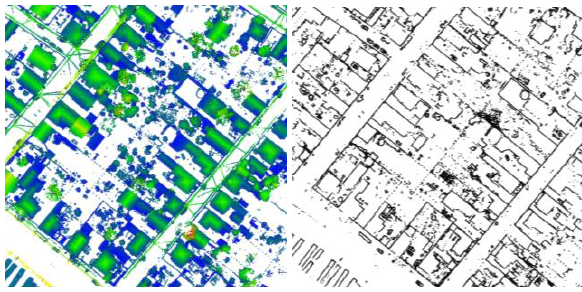
Figure 4 . Normalised point cloud filtered by elevation, left above 2.5m, right below 2.5m.